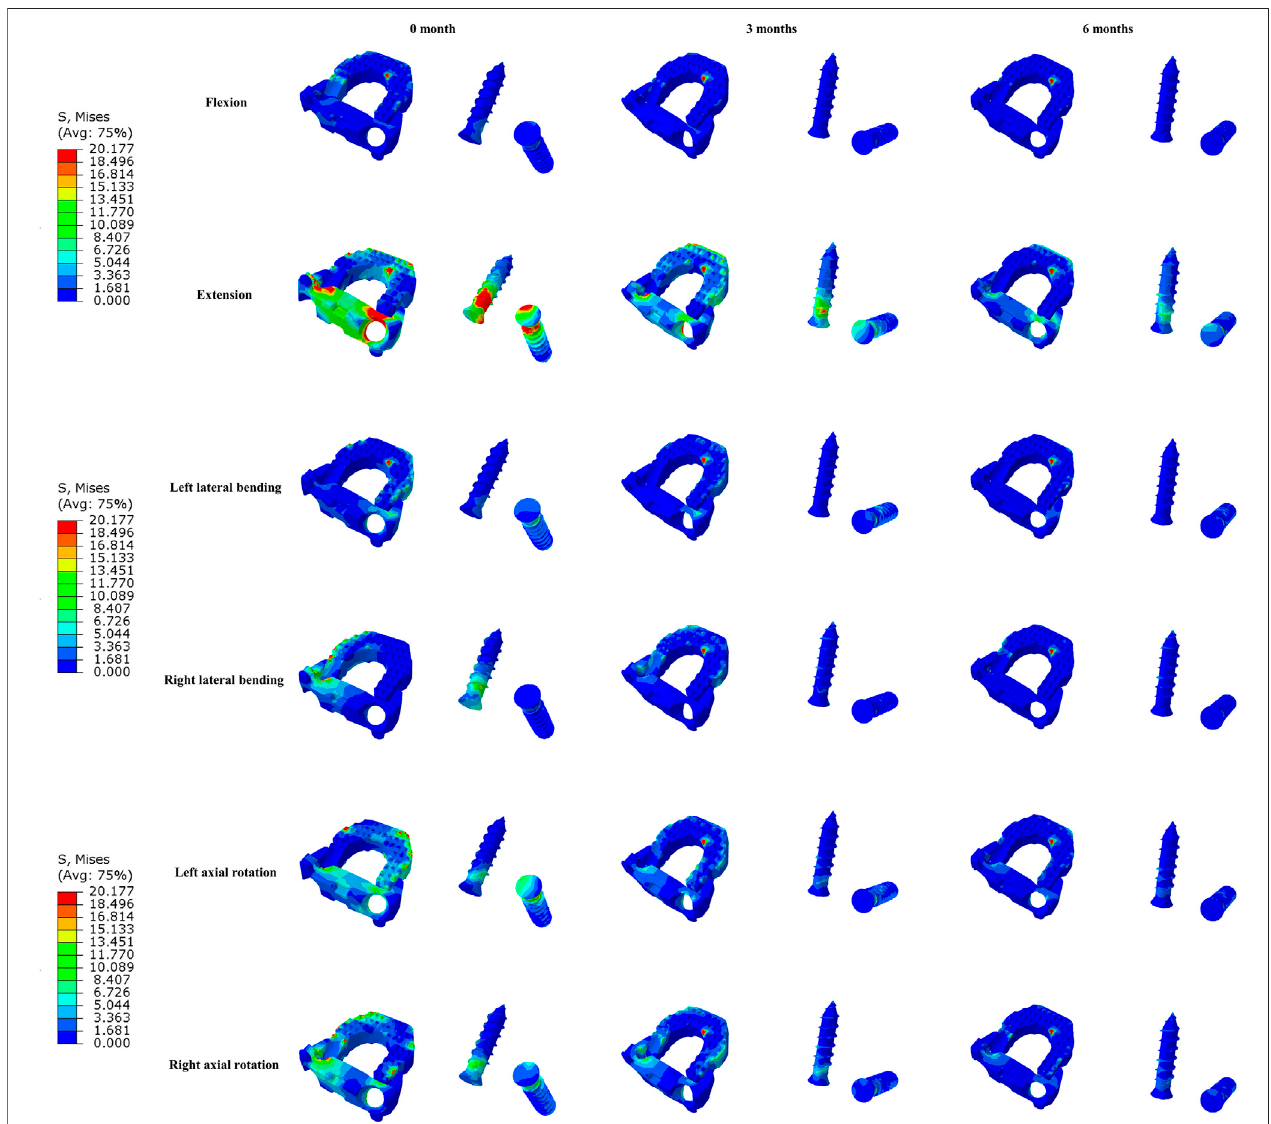
FIGURE 6 | The Von Mises stress distribution on the surfaces of interbody fusion cage and screws at different fusion stages in all loading conditions.